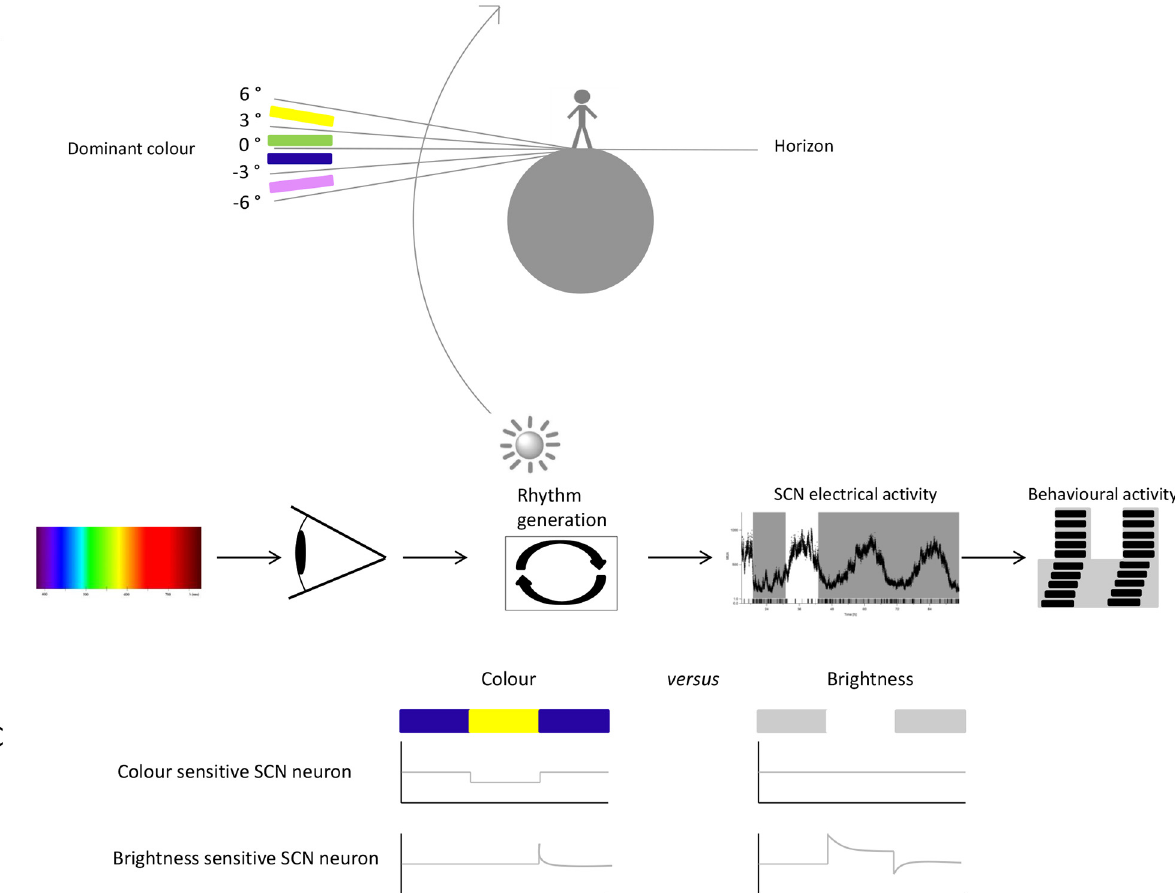
Fig 1. Colour detection by the circadian system. Colour detection by the circadian system. (A) Spectral changes in light reaching the earth during twilight. At negative solar angles, short wavelength light is dominant, while at positive solar angles, long wavelength light is dominant. (B) Schematic overview of light signalling to the SCN resulting in entrainment to a light-dark cycle. Light is the main entraining signal that adjusts the endogenous period length to the day- night cycle. Electrical activity of SCN neurons is the main output signal of the SCN, which leads to temporal regulation of behavioural activity. (C) Schematic depiction of two types of light-responsive neurons observed in the SCN as shown by Walmsley and colleagues: the colour-sensitive neuron (upper traces) and the brightness-sensitive neurons (lower traces). Image credit : Hester van Diepen .